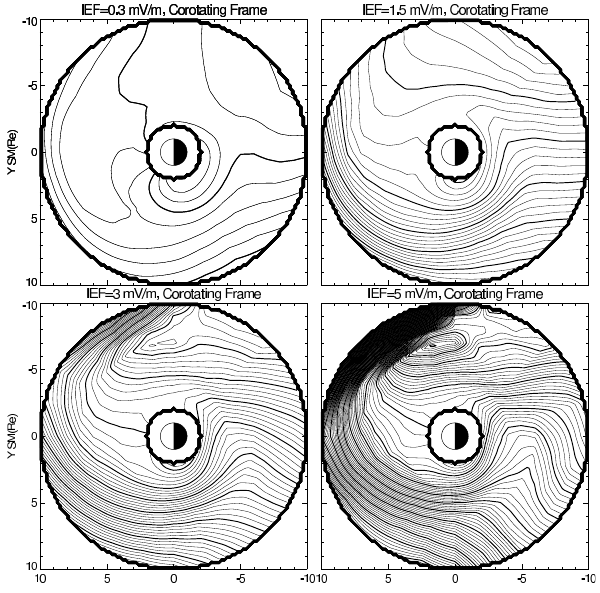
Fig. 6. Interpolated or extrapolated electric potential patterns at IEF=0.3, 1.5, 3, and 5mV/m. The format of the figure is the same as Fig.